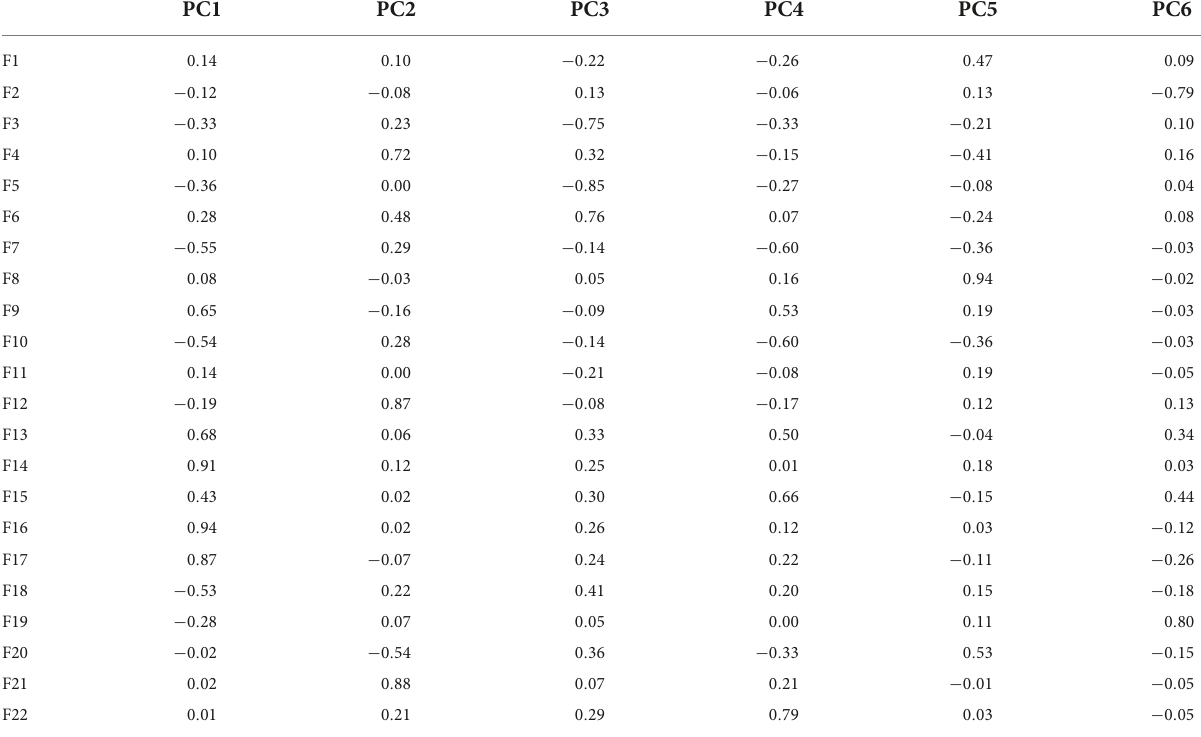
TABLE 6 Orthogonal rotation component matrix of the principal components.